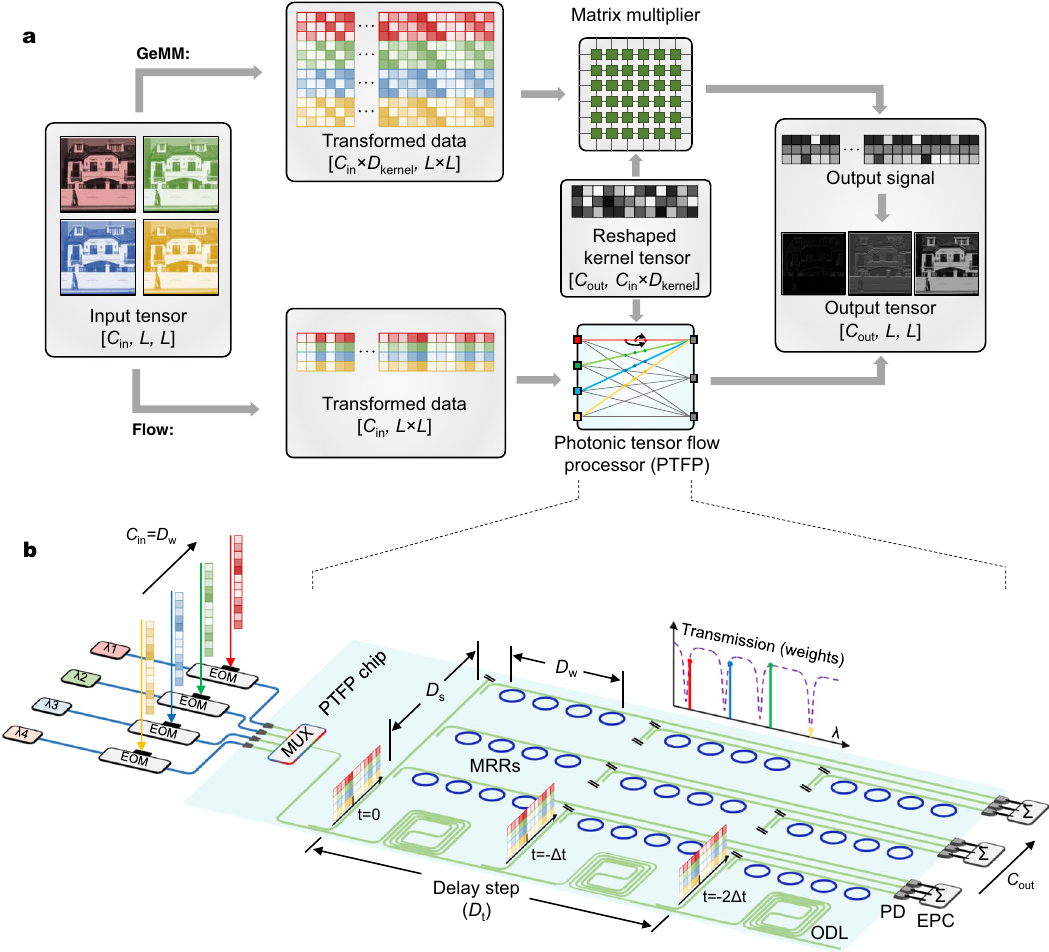
Fig.1|BasicprinciplesofthePTFP.a PrinciplesoftheconventionalGeMMandthe PTFP. Before matrix multiplication, the GeMM reshapes and duplicates the input tensor ([ C in , L , L ]) to the transformed data ([ C in × D kernel , L × L ]). Input data is dupli- cated D kernel times. After the matrix multiplier, outputs are yielded and can be reconstructed to convolved feature maps. In the PTFP approach (marked with ‘ Flow ’ ),theinputtensorisreshapedandentersthePTFPinserial.Eachinputchannel istemporallymodulatedontoanindividualwavelength.AlineinthePTFPschematic represents a convolutional operation between an input channel and an output